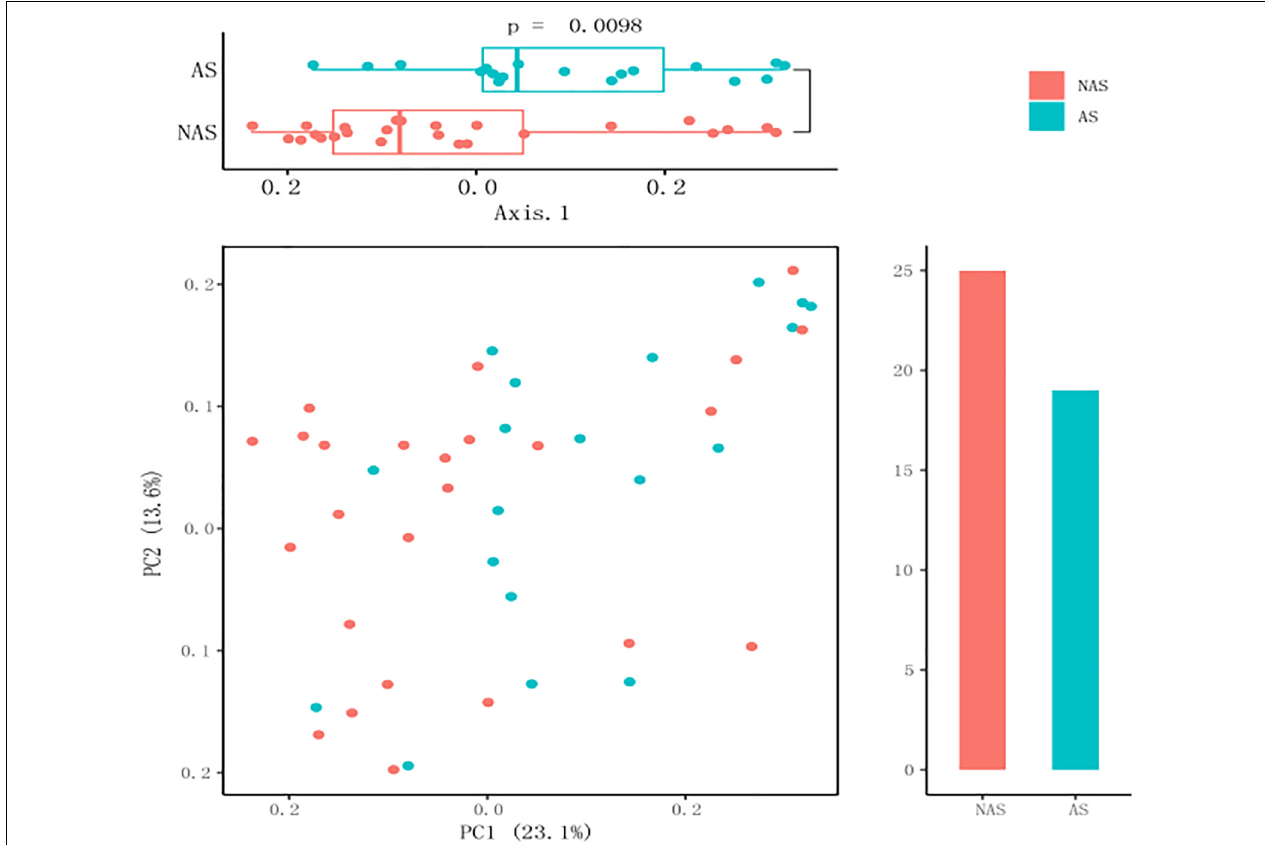
FIGURE 2 | A principal coordinate analysis (PCA) plot based on 16S rDNA sequencing of 64 lower respiratory tract (LRT) samples. The scatter plot shows principal coordinate 1 (PC1) vs. principal coordinate 2 (PC2). The percentages shown are percentages of variation explained by the components. The PCA profile of microbial diversity across all samples using the Bray–Curtis